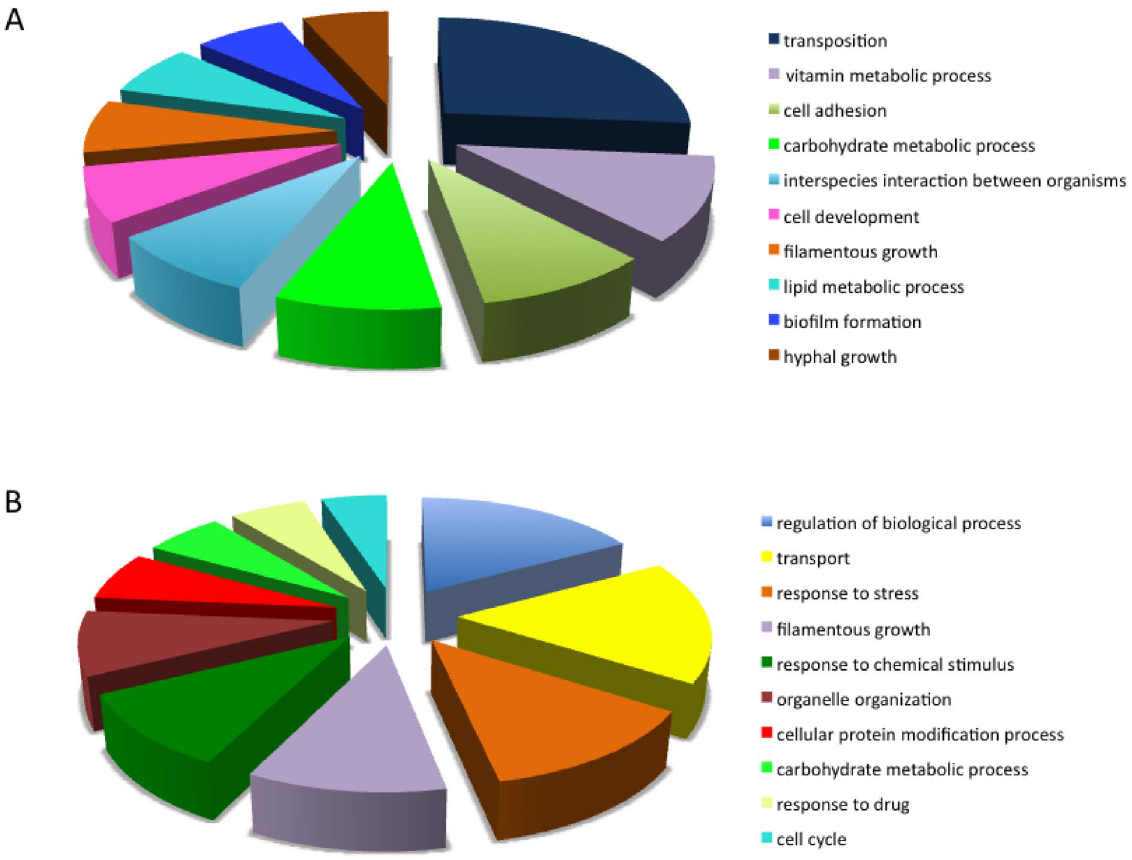
Figure 1. Ten most represented functional categories affected by growth of C.albicans in spaceflight conditions. The top ten of functional categories was determined by calculating (A) the ratio of the number of genes in category X to the total number of genes in the genome assigned to category X, and (B) the ratio of the number of genes in category X to the total number of genes differentially regulated by spaceflight.